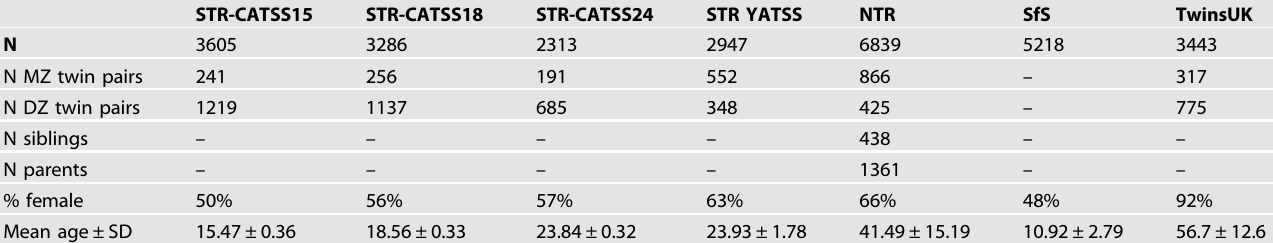
Table 1. Overview of cohorts included in the GWAS meta-analysis of